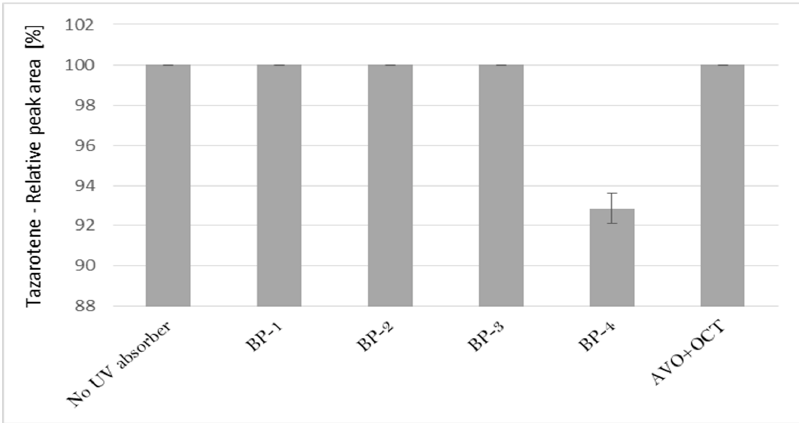
Figure 2. The relative peak area of tazarotene following UV irradiation in the presence of UV absorbers: absorbers: BP-1 (benzophenone-1), BP-2 (benzophenone-2), BP-3 (benzophenone-3), BP-4 BP-1 (benzophenone-1), BP-2 (benzophenone-2), BP-3 (benzophenone-3), BP-4 (benzophenone-4), and (benzophenone-4), and AVO + OCT (avobenzone + octocrylene). AVO + OCT (avobenzone +